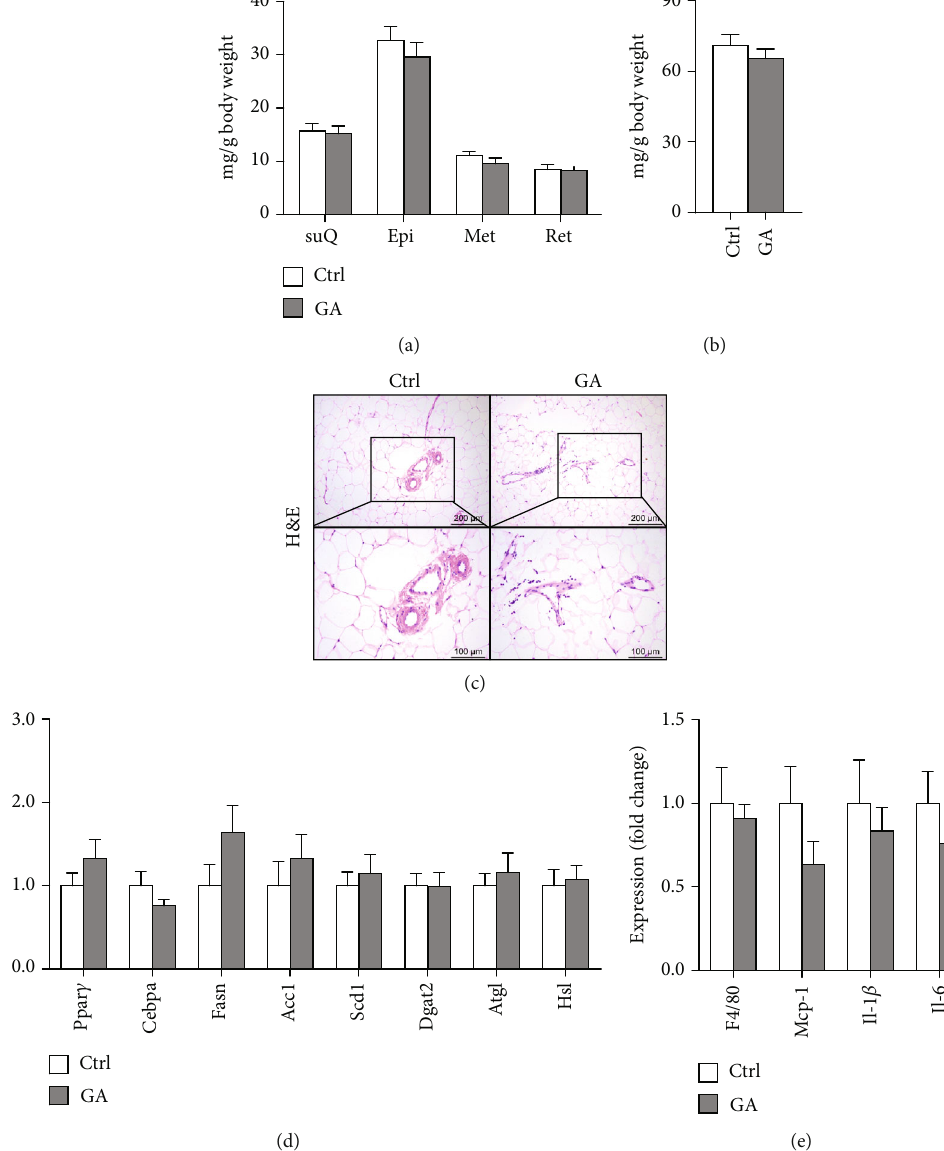
Figure 3: E ff ect of low-dose GA administration on diet-induced adipogenesis in the Apoe KO mice. (a, b) Weight of WATs, measured by counting weight of subcutaneous (suQ), epididymal (Epi), mesenteric (Met), and retroperitoneal (Ret) WAT separately (a) or together (b). (c) Representative H&E staining images of Epi WAT section. (d) Quantitative real-time PCR analysis of adipogenesis-related gene expression in Epi WAT. (e) Quantitative real-time PCR analysis of in fl ammation-related gene expression in Epi WAT. n = 6 -8 per